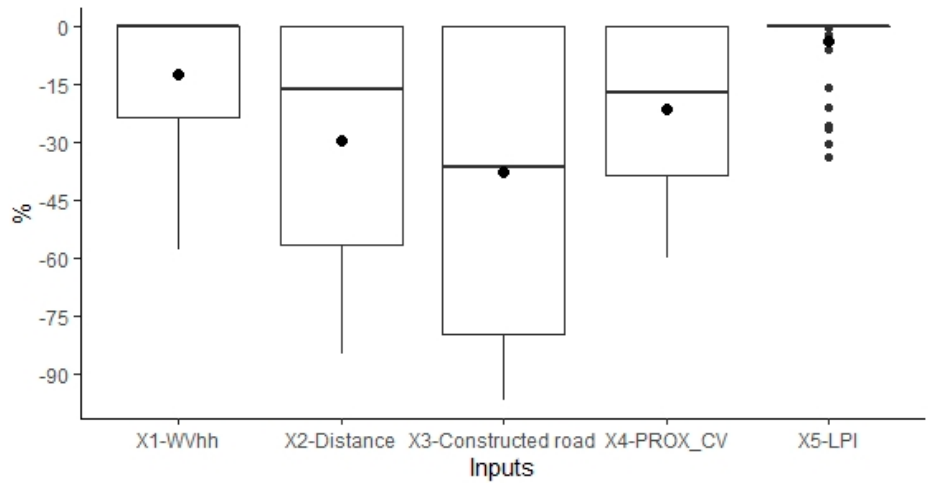
Figure 5. Target projected reductions for each input variable according to DEA analysis. Black dots present the mean value.